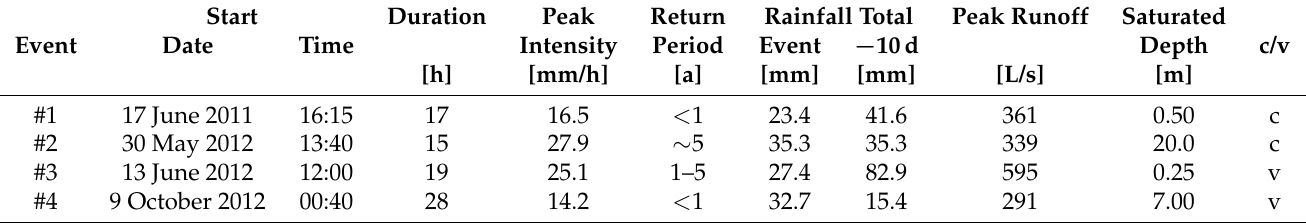
Table 4. Overview of events with highest peak runoff in the runoff time series, covering the years 2011–2012. ‘Saturated depth’ is the initial condition guess used for each event, while the last column (‘c/v’) indicates whether the event is used for calibration (c) or validation